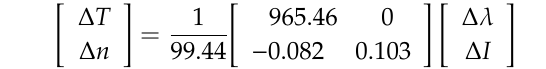
Table 1. Comparisons of various fiber RI sensors.